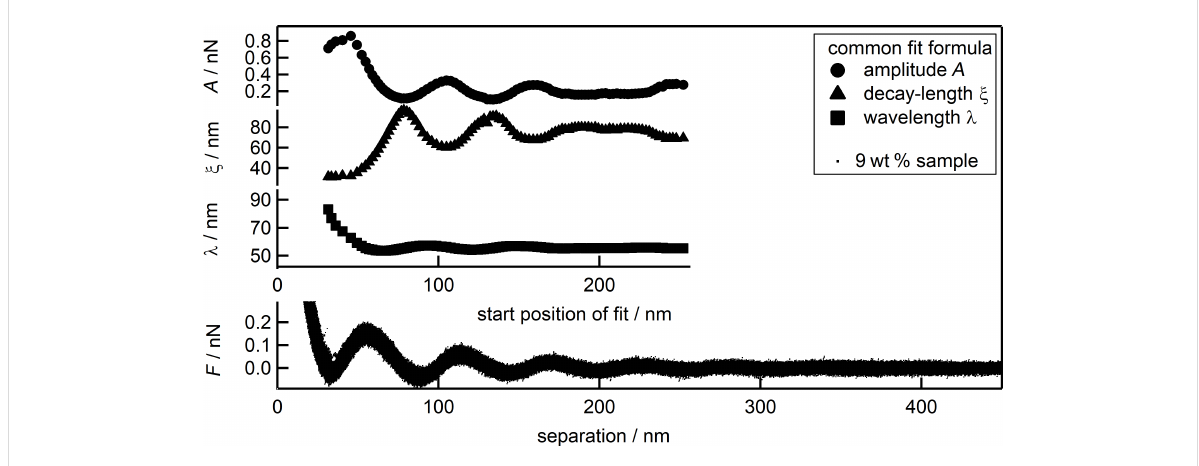
Figure 3: Combined force data of the 9 wt % suspension (black dots) together with the fit parameters A (circles), ξ (triangles) and λ (squares) as a function of the separation or the starting point of the individual fit, respectively.